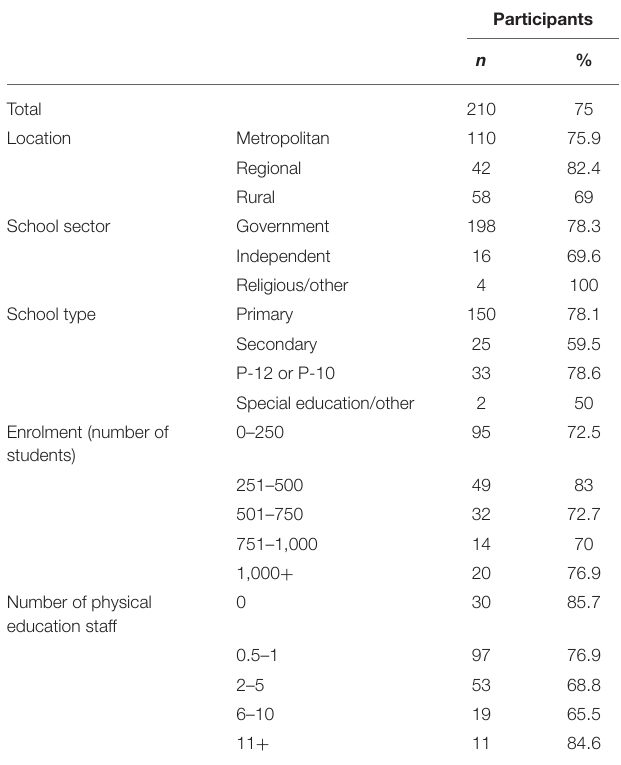
TABLE 2 | Schools that reported outsourcing physical education to external